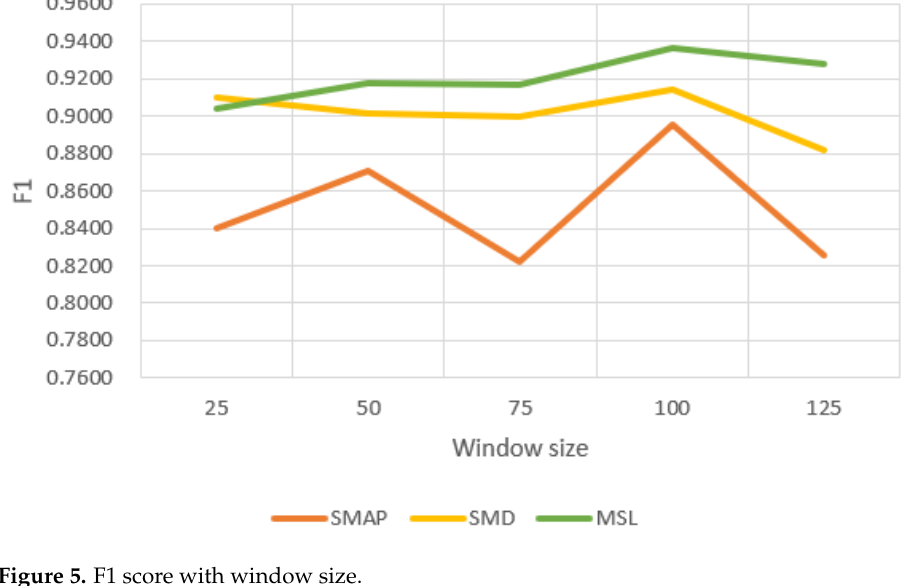
Figure 5. F1 score with window size.